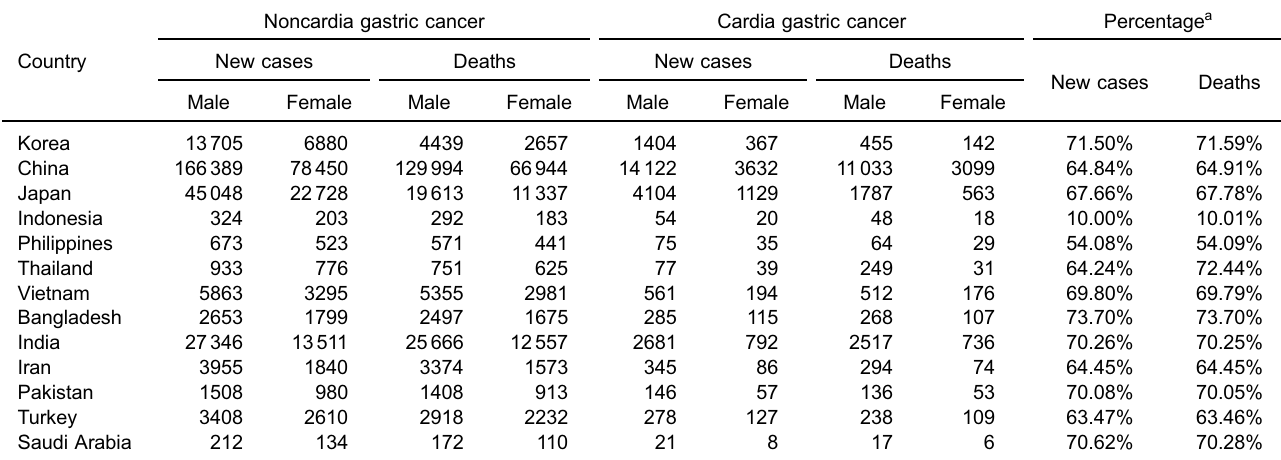
Table 8. Estimated new cases and deaths of HP-related gastric cancer in 2012, by country